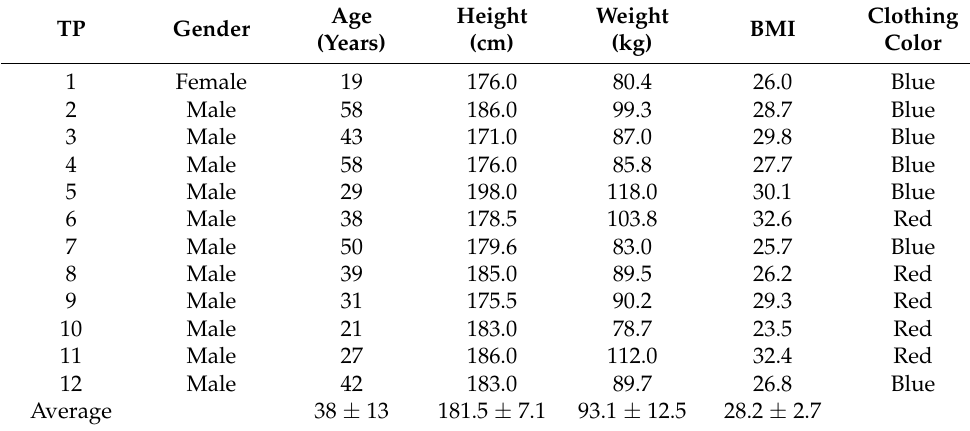
Table 1. Characteristics of test persons